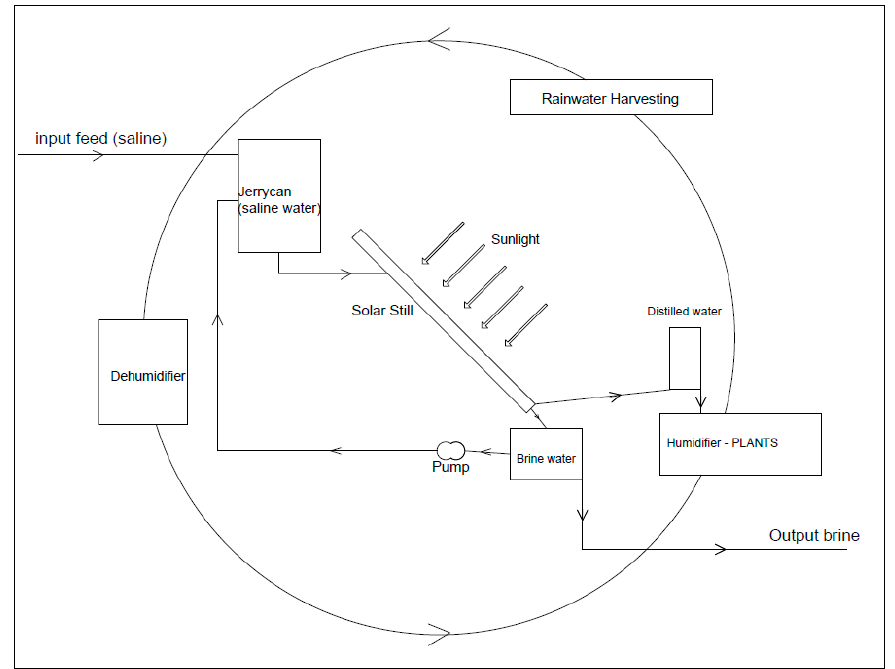
Figure 4. Water flow through the system including the desalination and zero-liquid-discharge (ZLD).